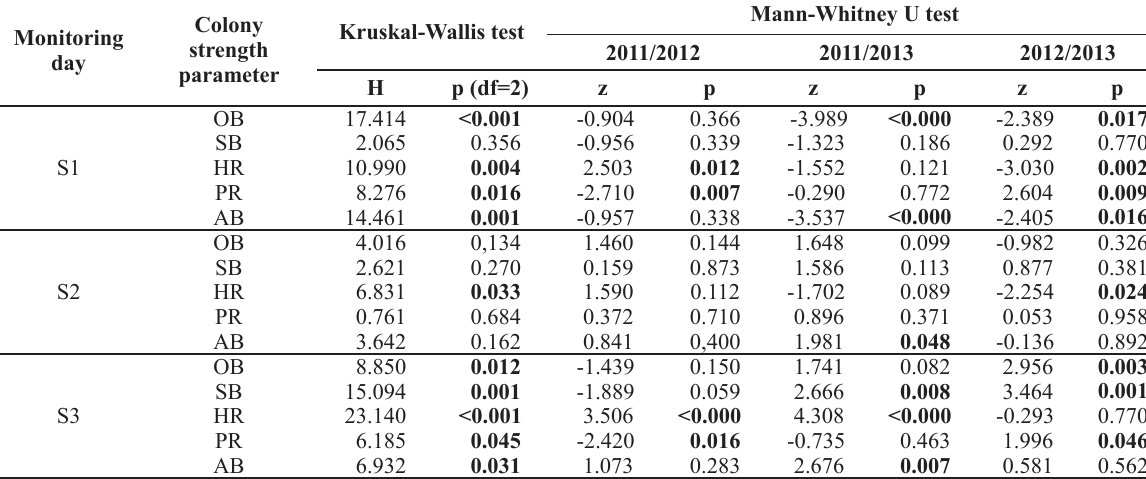
Differences in colony strength parameters in three consecutive years in honey bee colonies treated with AbM extract (100